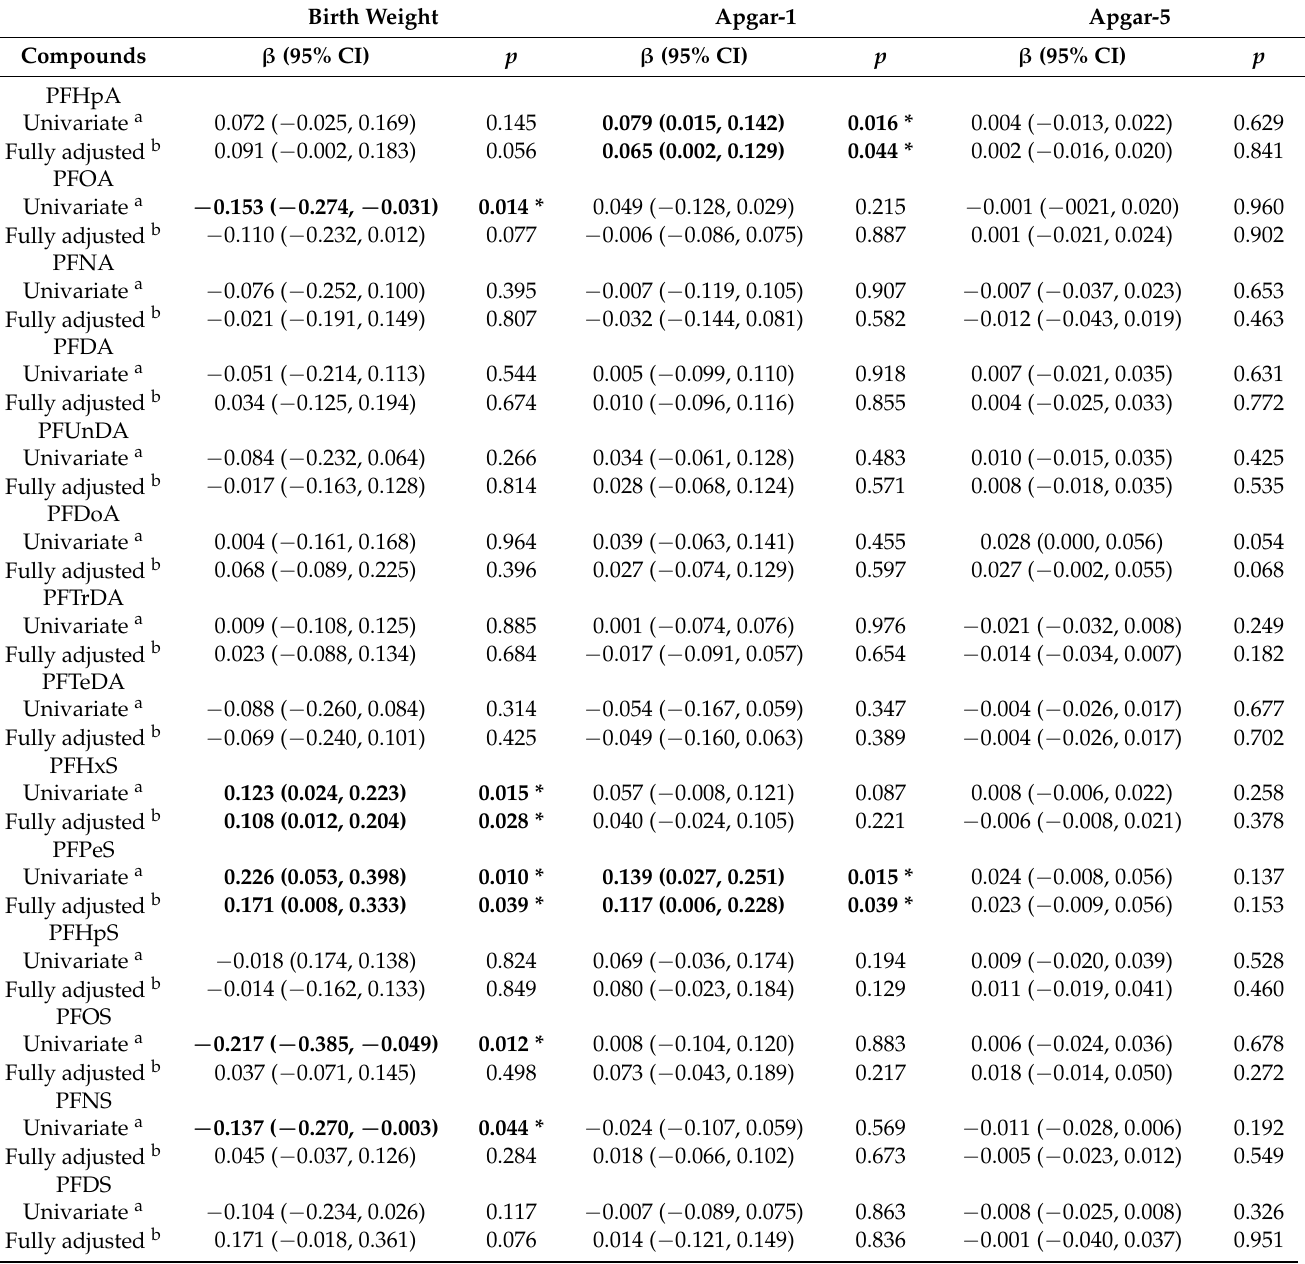
Table 2. Multivariable linear regression analyses of serum PFASs in relation to birth weight and Apgar scores. Birth Weight Apgar-1